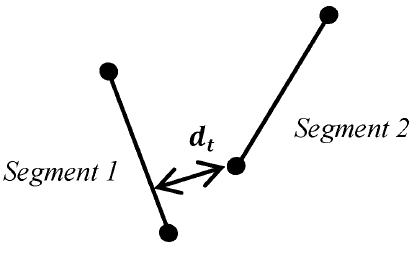
Figure 9. Shortest distance between an end node and another segment.